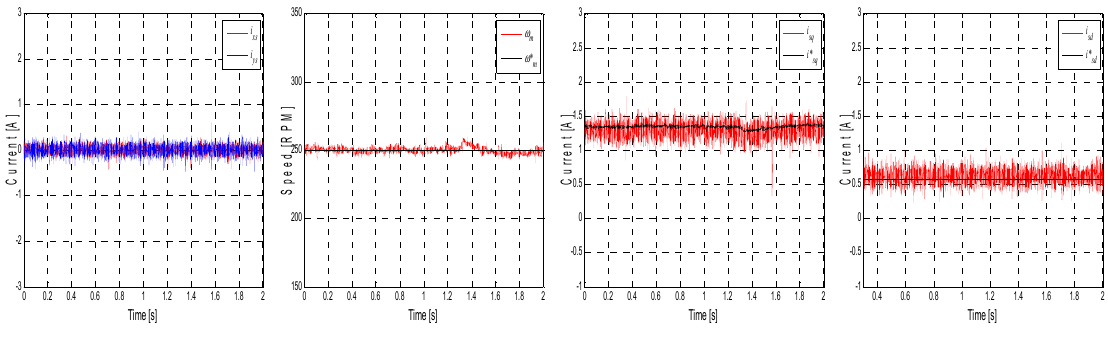
Figure 5. Experimental validation at operating speed of 250RPM.